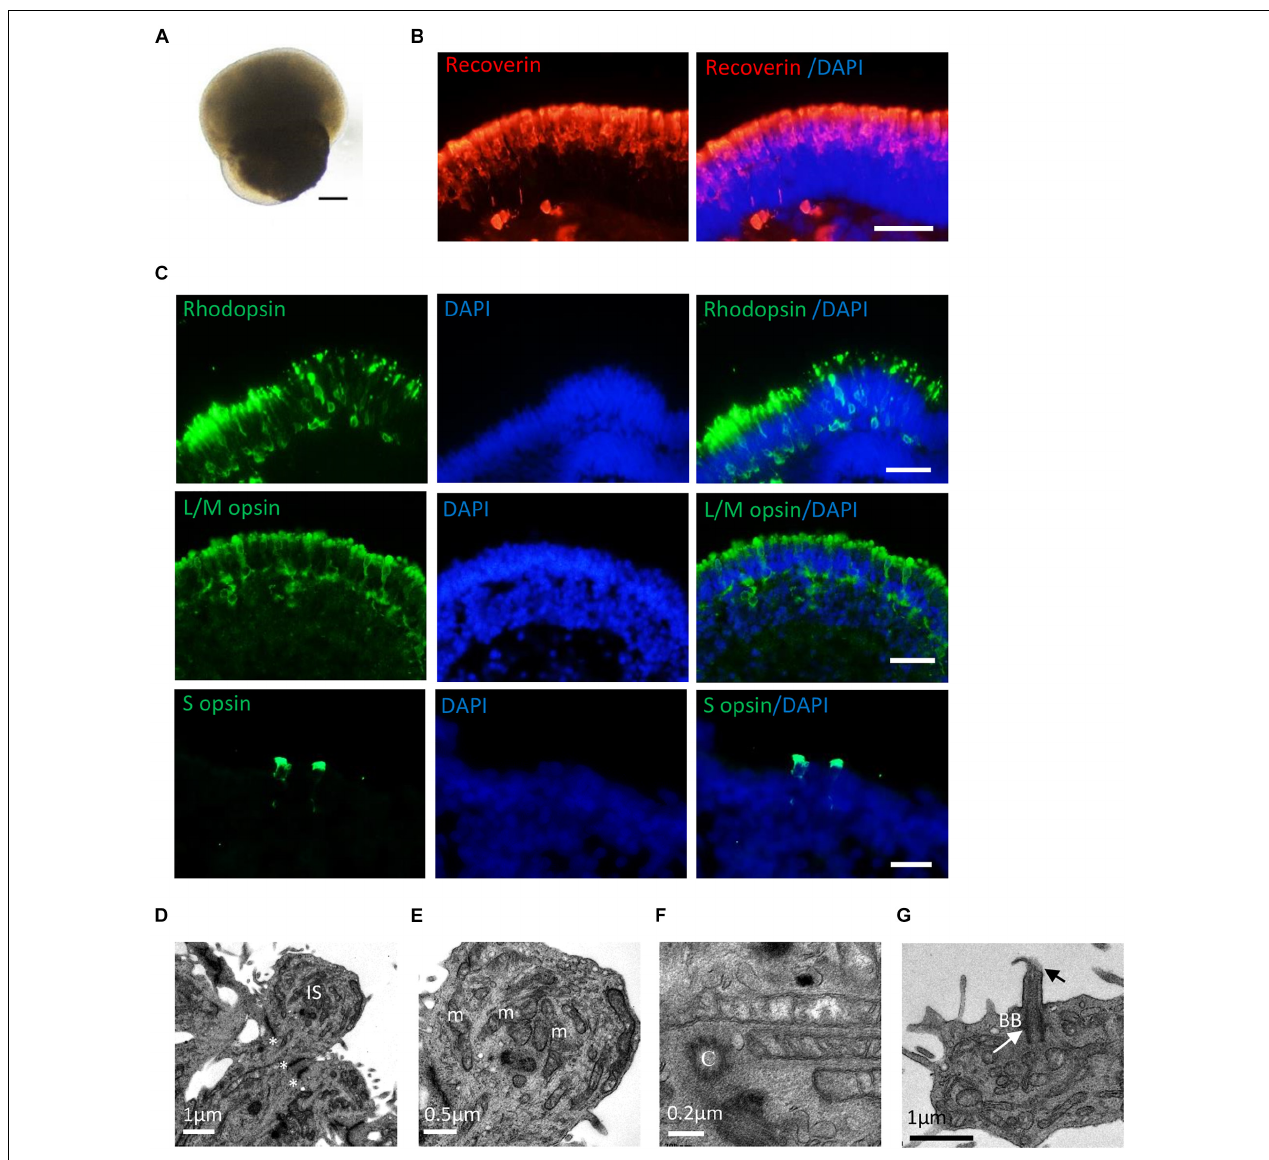
FIGURE 5 | Photoreceptor subtype specification in patient retinal organoids. (A) Representative images of retinal organoids derived from RPE65-hiPSCs on D150. Scale bars, 200 µ m. (B) Photoreceptor cells developed outer nuclear layer-like structure in patient retinal organoids, expressing photoreceptor cell pan marker Recoverin. Scale bar, 20 µ m. (C) The patient photoreceptor cells had capacity to develop all subtypes including Rhodopsin + rods, L/M opsin + red/green cones and S opsin + blue cones. Scale bars, 20 µ m. (D–G) TEM revealed that RPE65-hiPSC-derived photoreceptors developed typical ultra-structures, outer limiting membrane (OLM, asterisks), inner segment (IS) with rich mitochondria (m), centriole (C), basal body (BB) (white arrow), and connecting cilia (black arrow). Scale bars, 1 µ m (D) , 0.5 µ m (E) , 0.2 µ m (F) , and 1 µ m (G)